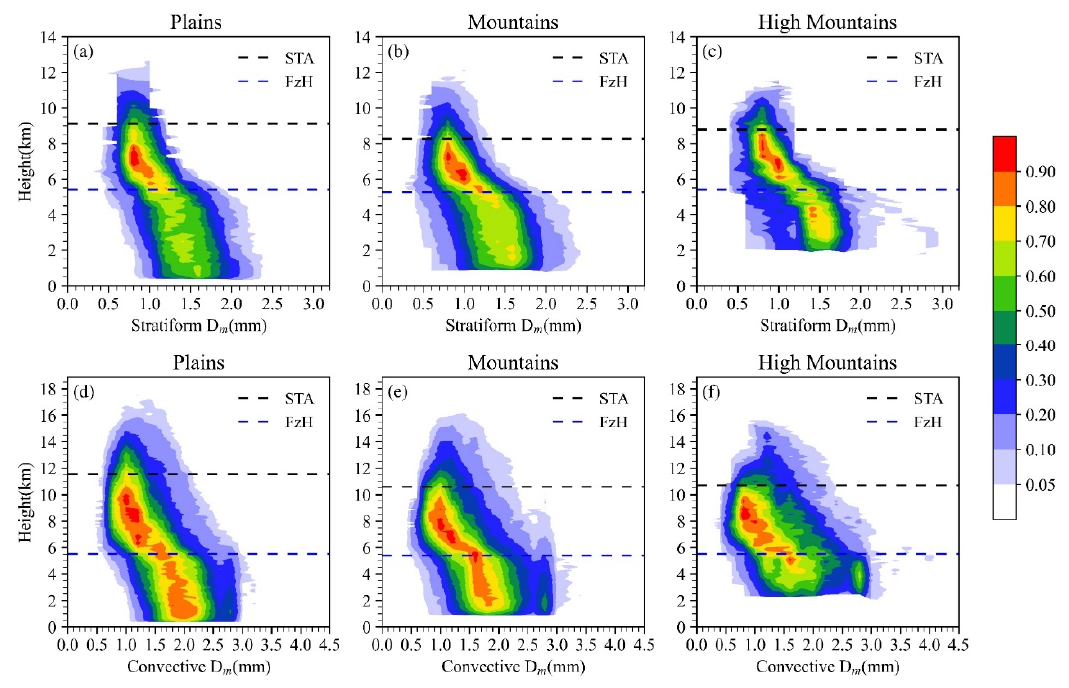
Figure 6. NCFAD of D m of two types of heavy precipitation over plains ( a , d ), mountains ( b , e ), and high mountains( c , f ). The color areas indicate occurrence frequency of D m . The black and blue dash lines represent STA and FzH, respectively.